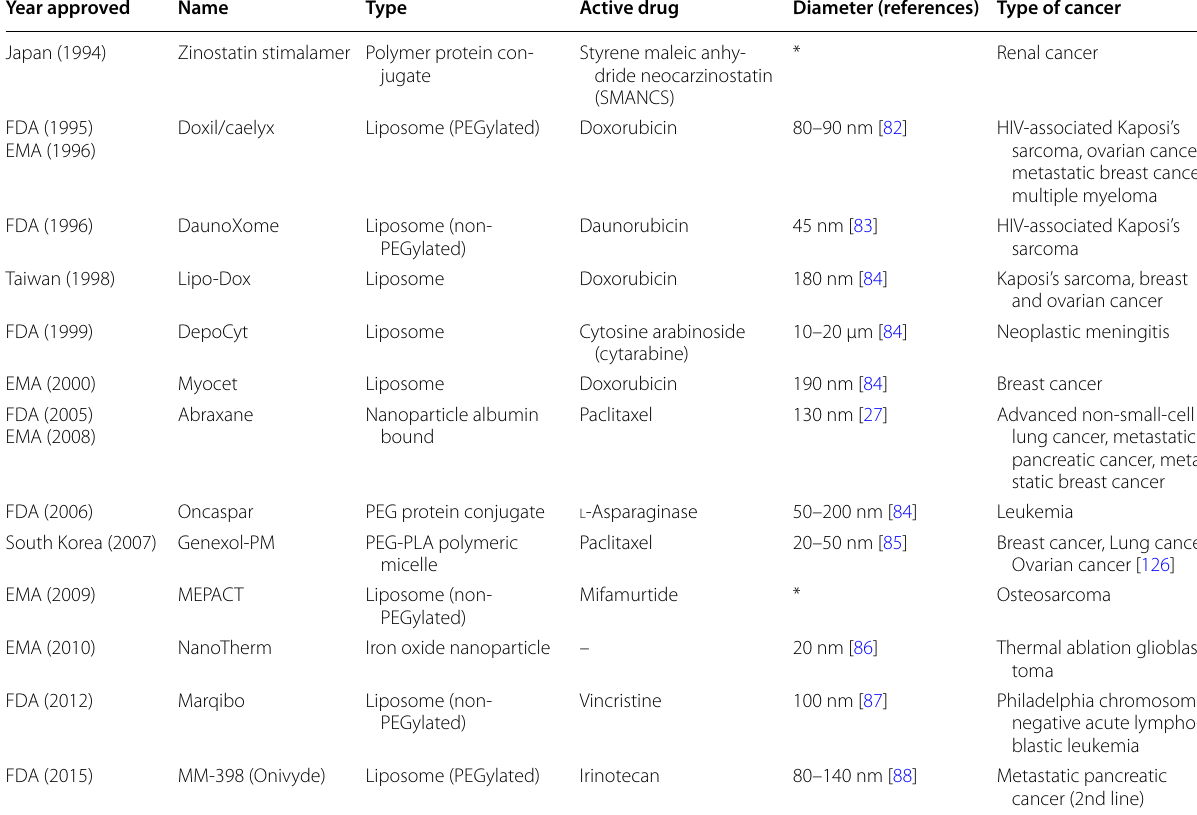
* Data could not be